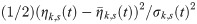
Improvement of model fitting by using CVaR (k-max) MAP formulation (P1, Model 1).Model fits for 4 experiments selected among the experiments with 10 largest prediction errors (1/2)(ηk,s(t)−η¯k,s(t))2/σk,s(t)2. The model fits from standard MAP formulation (dotted line) are compared with the model fits from CVaR formulation with β = 0.9 (solid line). (a) gLV model fits to pairwise community experiment of PC in the presence of EL. (b) gLV model fits to pairwise community experiment of CA in the presence of ER. (c) gLV model fits to pairwise community experiment with CH in the presence of PC. (d) gLV model fits to pairwise community experiment with CH in the presence of BO.